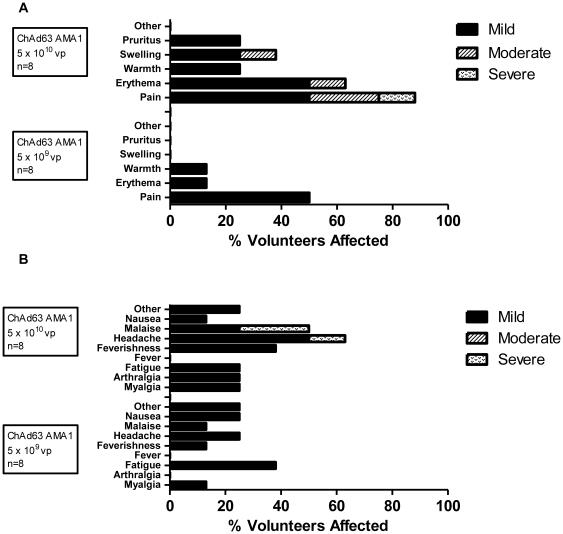
Local and systemic AEs deemed definitely, probably or possibly related to ChAd63 AMA1.Only the highest intensity of each AE per subject is listed. Data are combined for all AEs for all volunteers receiving the same vaccine at the stated dose. There were no immunization related serious AEs. (A) Local AEs post ChAd63 AMA1. (B) Systemic AEs post ChAd63 AMA1. ‘Other’ AEs post 5×109 vp ChAd63 AMA1 included cough, coryzal symptoms, abdominal pain and dysmenorrhoea. ‘Other’ AE post 5×1010 vp ChAd63 AMA1 was coryzal symptoms. All ‘other’ AEs were considered possibly related to vaccination due to a temporal association.